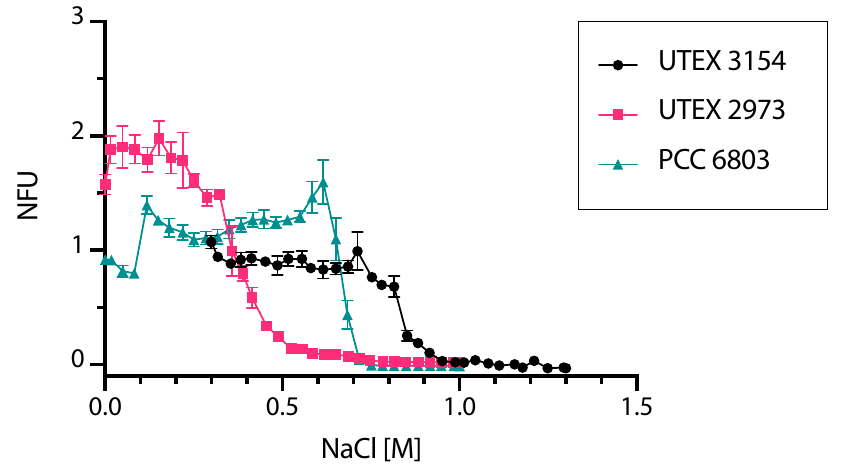
Figure 5. 1D screening of NaCl tolerance in cyanobacteria. Normalized autofluorescence after 7 days in response to varying concentrations of NaCl shown for three different cyanobacterial strains, UTEX 3154, UTEX 2973 and PCC 6803. Data points are averages of 10 ± 3 droplets. Error bars represent standard deviation. Normalized autofluorescence is shown as